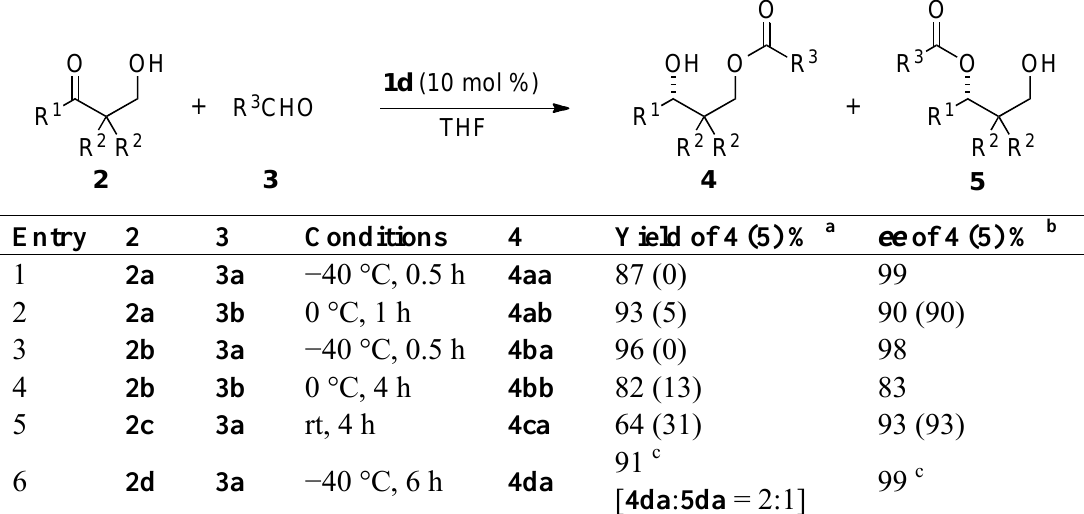
Table 2. Evans-Tishchenko reduction of various achiral β -hydroxy